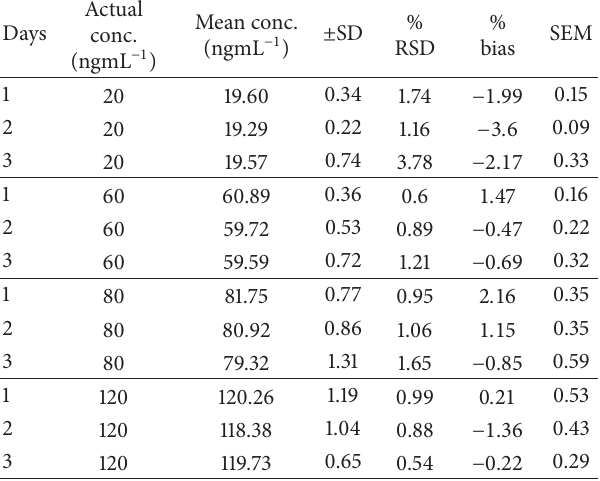
a Percentage relative standard deviation for six replicate samples. b Percentage relative error for six replicate samples. c Limit of detection. d Limit of quantitation. Table 2: Accuracy of the spectrofluorimetric method for determi- nation of